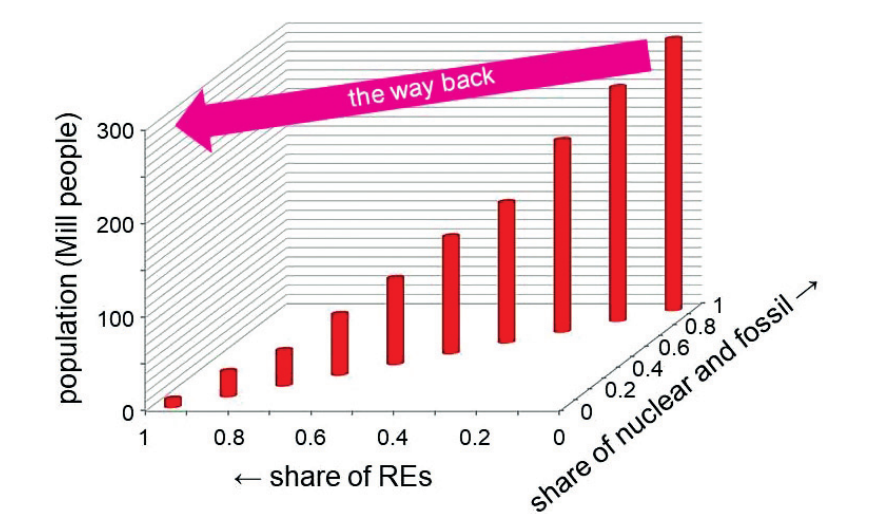
Fig. 1. – Growth of the US population between 1835 and 2009 plotted against the share of renewable, nuclear and fossil energy.